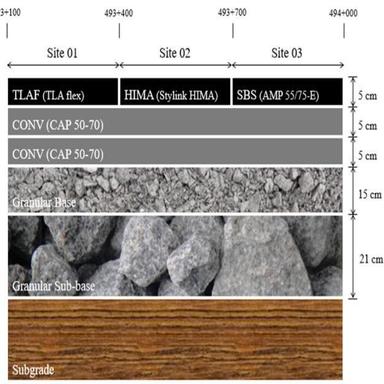
- Experimental sites structure.